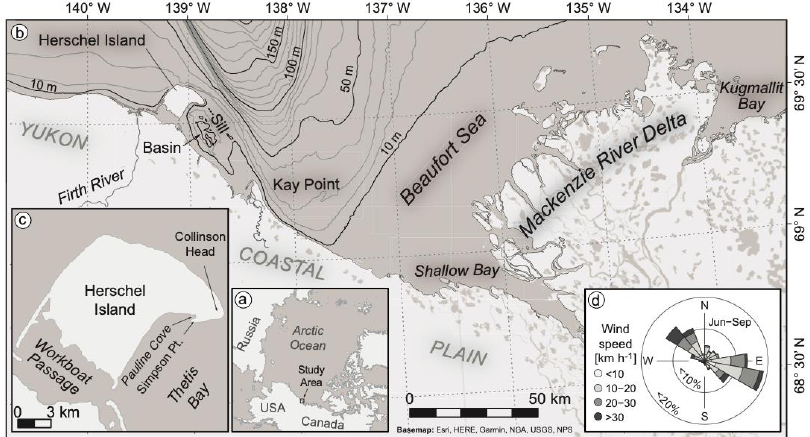
Figure 1. ( a ) The study area is located in the Canadian Beaufort Sea, ( b ) specifically in the vicinity of Herschel Island — Qikiqtaruk with the Mackenzie River to the east, and the Firth River to the west. ( c ) The focus of the study lies on two localities: Thetis Bay and Workboat Passage. ( d ) Note the bimodal wind distribution during the 1995 – 2016 open water seasons recorded at Herschel Island — Qikiqtaruk. [51 –